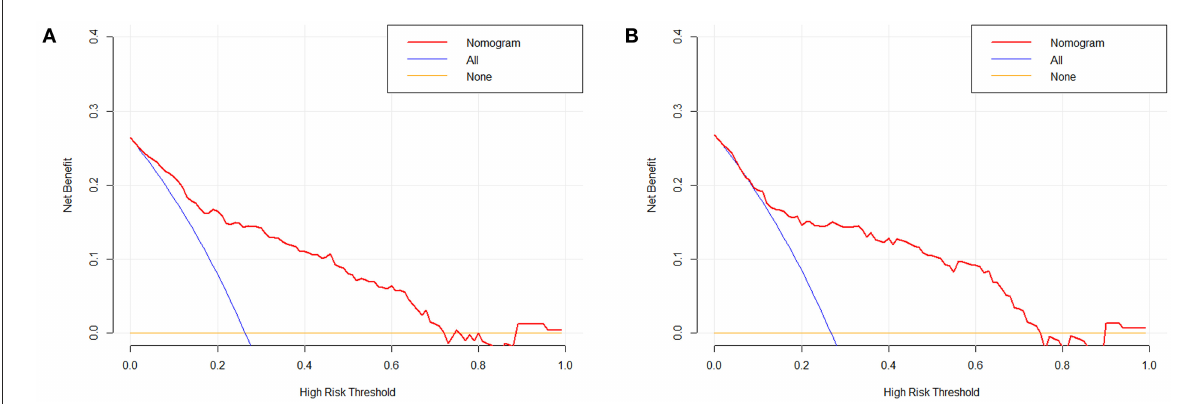
FIGURE7 Decision curve analysis of the nomogram in the training (A) and test cohort (B) . The x-axis indicates the threshold probability. The y-axis measures the net benefit. The blue line displays the net benefit of the strategy of treating all patients. The orange line illustrates the net benefit of the strategy of treating no patients. The red line indicates the nomogram. Decision curve analysis is a specific method developed for evaluating the prognostic value of nomogram strategies.